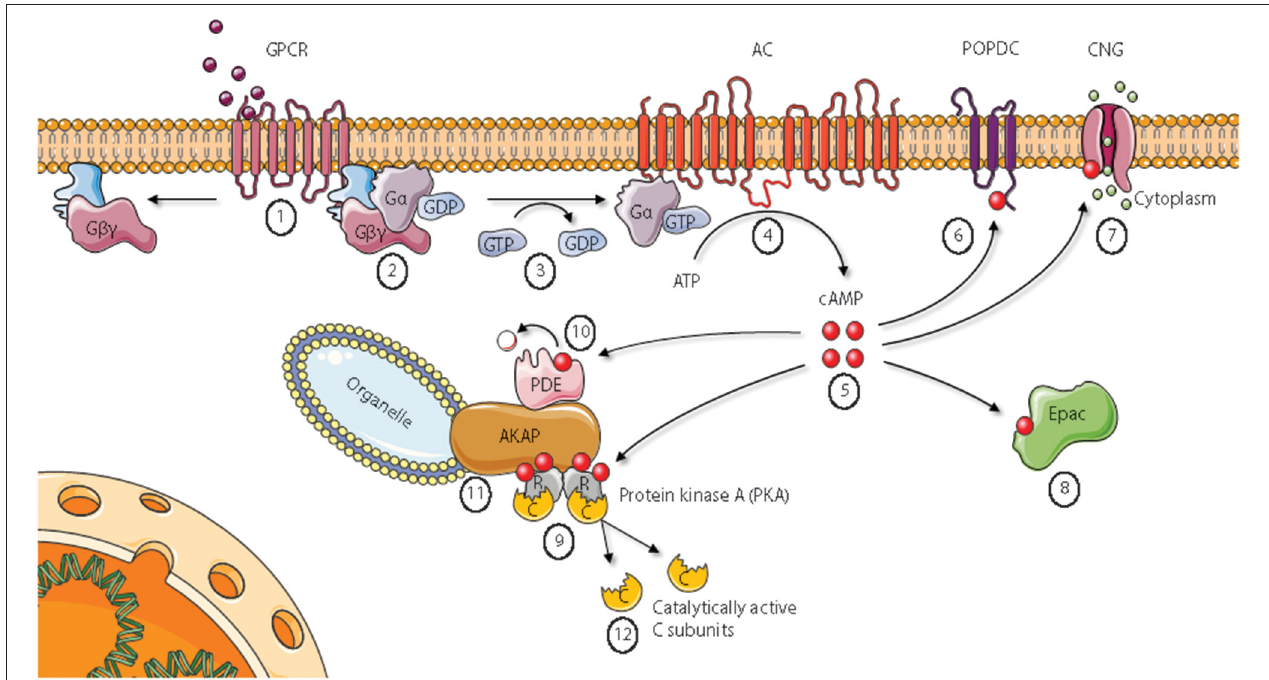
FIGURE 1 | Cyclic AMP signaling pathways. Epac, Exchange protein directly activated by cAMP; AKAP, A Kinase Anchoring Protein; PDE, phosphodiesterase. See main text for details. Figure based on Wong and Scott ( 2). Figure created using the Servier Medical Art resource (http://www.servier.com).